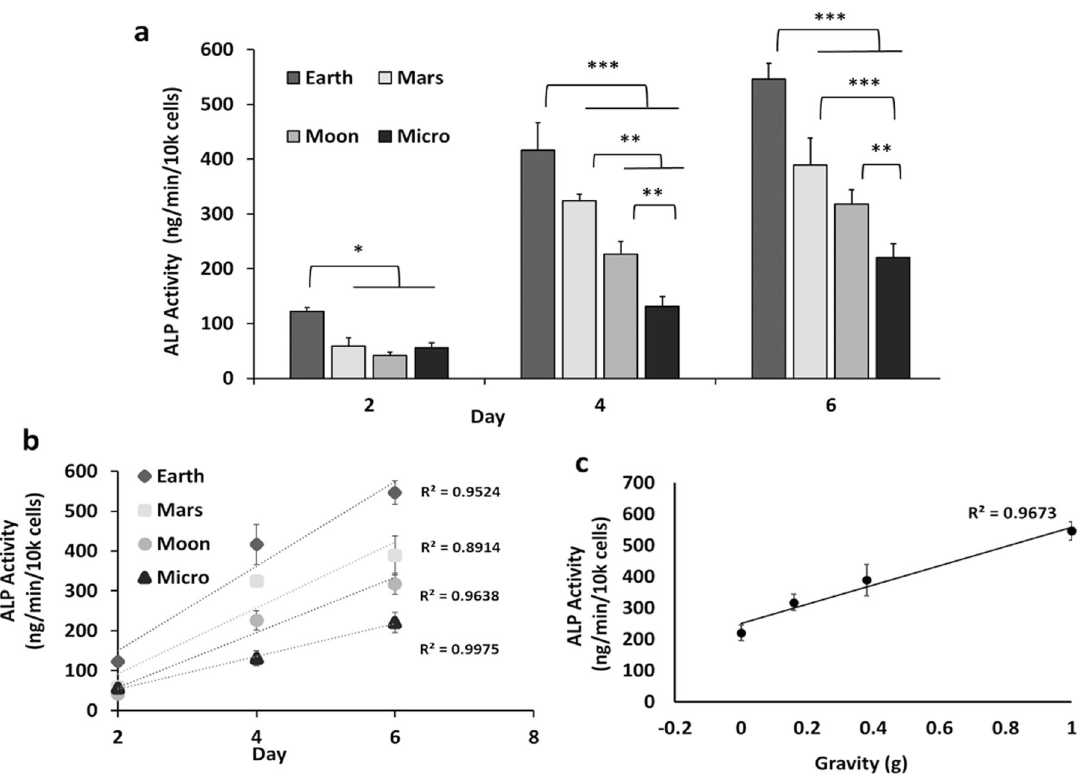
Fig. 2 Simulated partial gravity inhibits osteogenic differentiation in 7F2 osteoblasts. a ALP activity as a result of exposure to different simulated partial-gravity conditions at different time points ( N = 3). b ALP activity as a function of time between day 2 and day 6. c ALP activity as a function of altered simulated partial gravities at day 6. Data are presented as means ± standard deviation. Asterisk (*) shows p < 0.05, (**) shows p < 0.01, (***) p < 0.001 as determined by Tukey ’ s post hoc